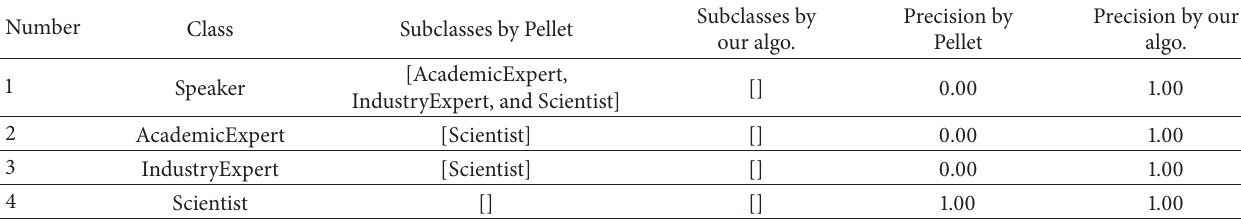
Figure 4: Cases of adding union and intersection classes in conference ontology. Table 8: Conference cases subclass calculation results: case2.